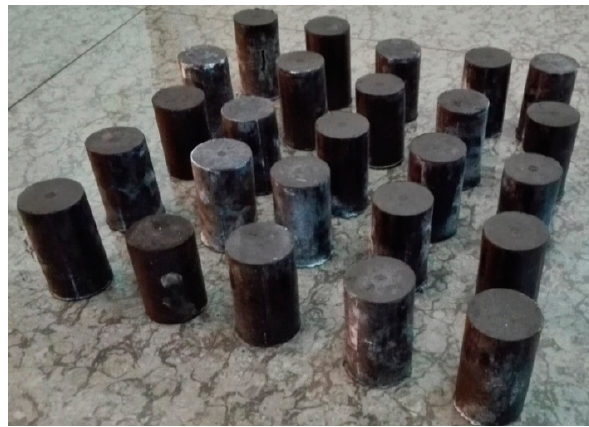
Figure 1. Coal samples.